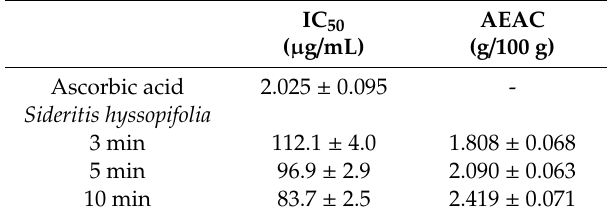
Table 1. IC 50 and Ascorbic acid Equivalent Antioxidant Capacity (AEAC) values of Sideritis hyssopifolia .